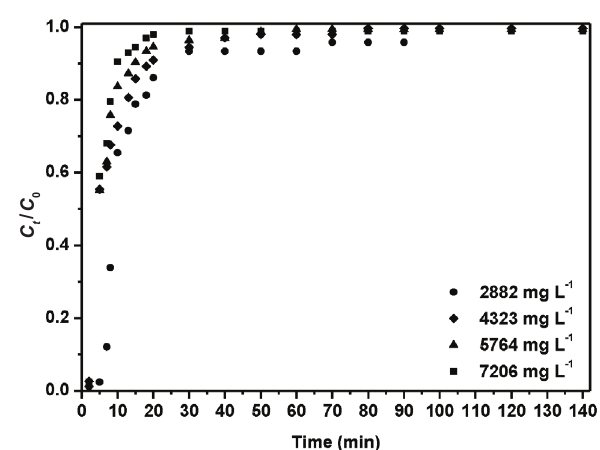
Fig. 2 – Effect of initial acrylic acid concentration on break- through curves for adsorption of acrylic acid onto CaO nanoparticles packed bed column (Z =10 cm, Q = 5 mL min –1 )